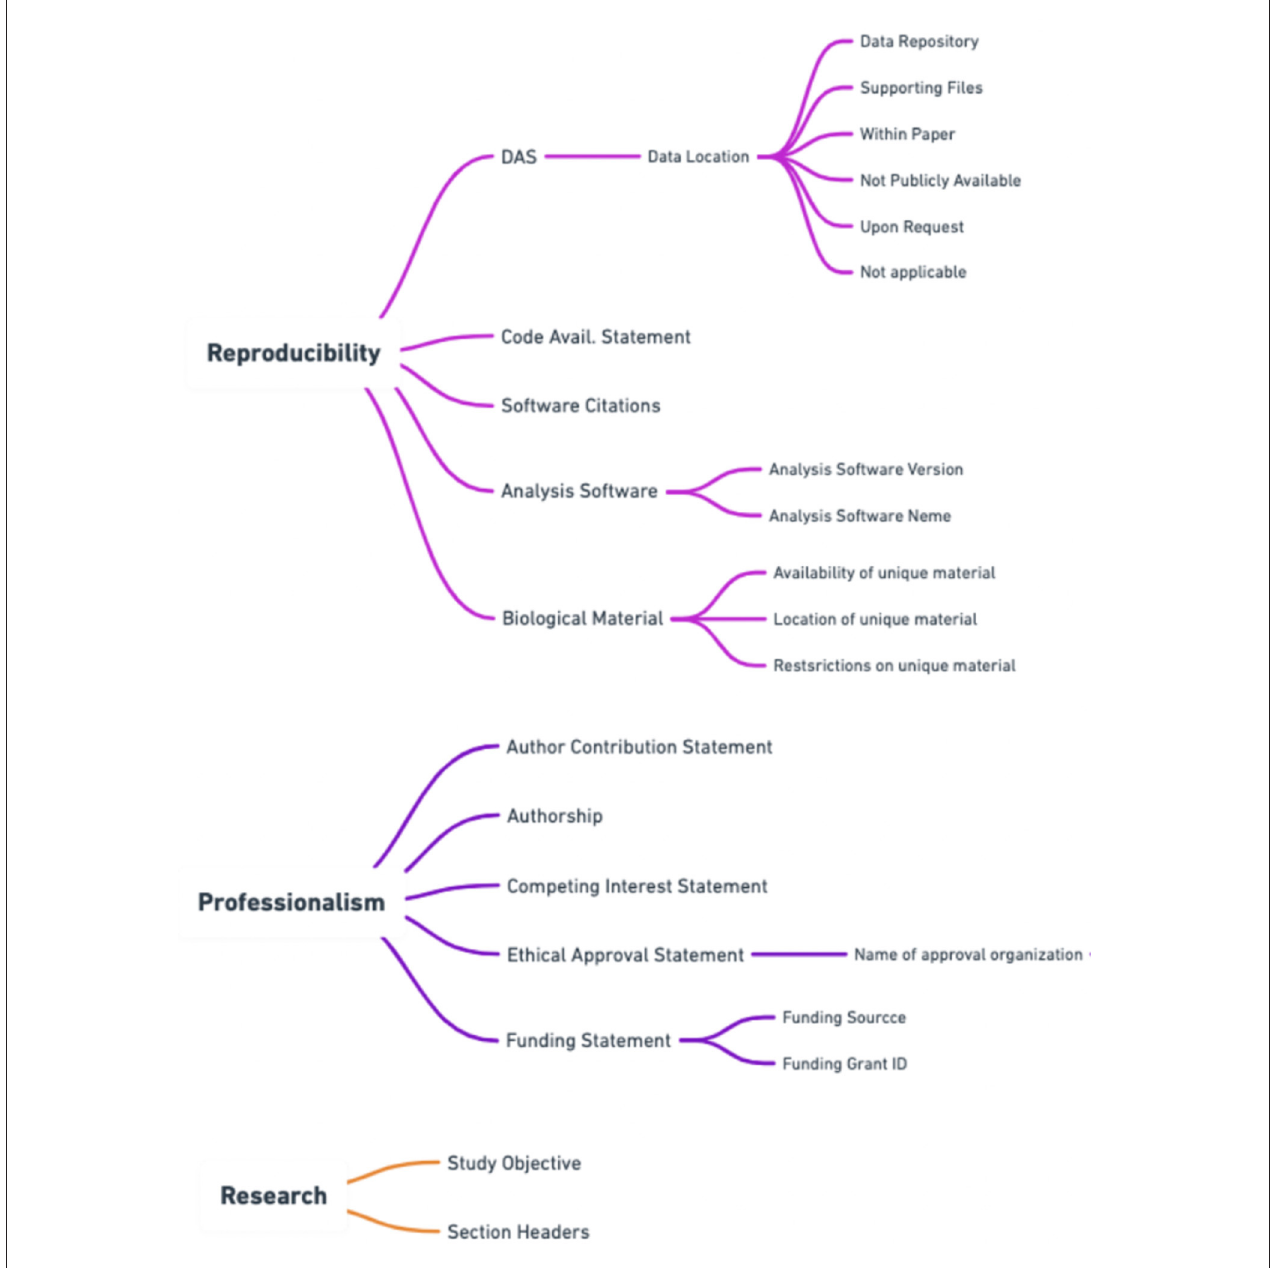
FIGURE 2 | Additional subsections within the ripetaScore that provide a more granular representation of the scientific quality of the